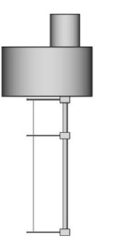
Figure 4. THW probe of tantalum wire with short and long wire placed on top of each other (adapted from Antoniadis et al. [39].